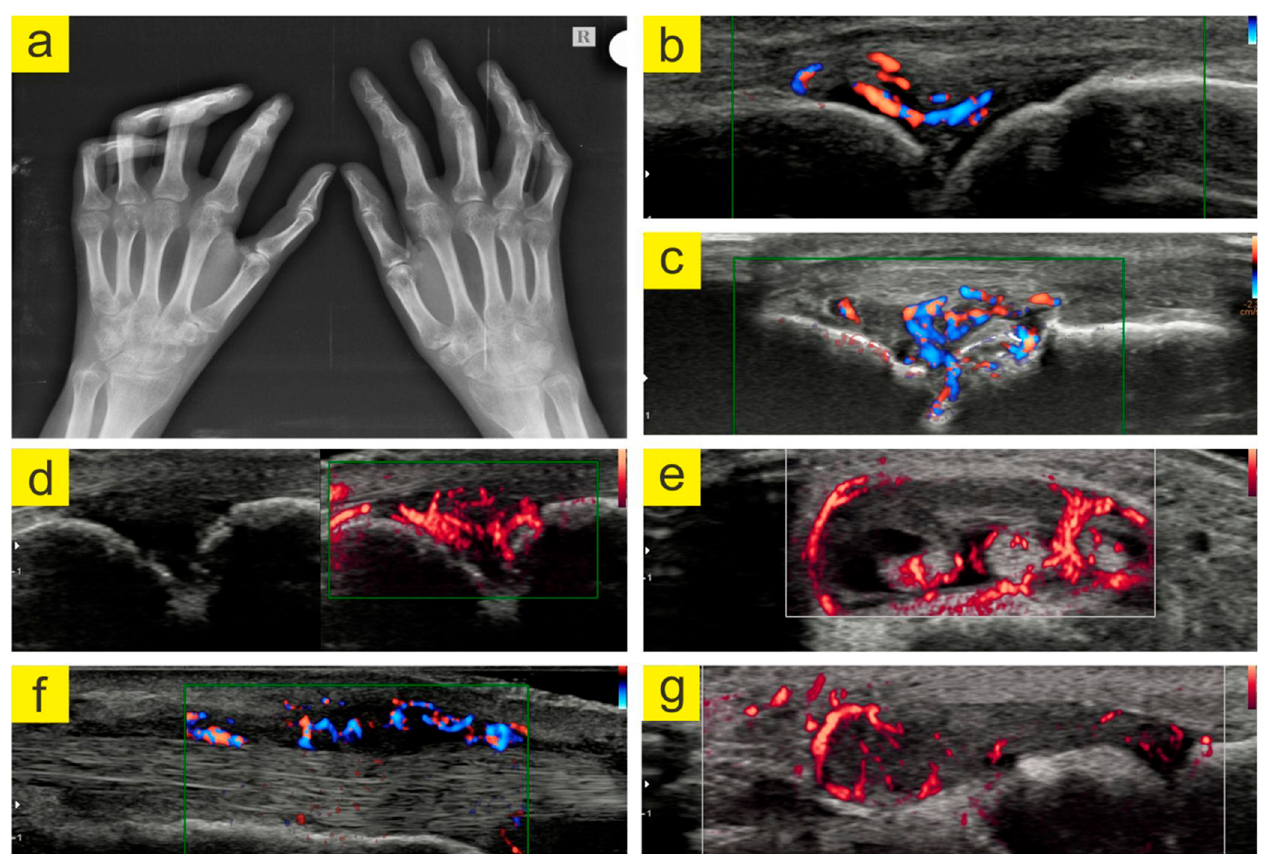
Figure 2. ( a ). Bilateral AP hand radiography. Radiological imaging identi fi ed multiple marginal ero- sions; narrowing of the proximal and distal interphalangeal, metacarpophalangeal, carpo-metacarpal, and carpal bone joints in both hands; osteoporosis in the band; subluxation proximal interpha- langeal II, III, IV, and V of the left hand; proximal interphalangeal IV and V of the right hand, and metacarpophalangeal IV and V of the right hand. ( b ). Hyper vascular synovial pannus (directional power Doppler). ( c ). Synovial pannus and bone erosion (directional power Doppler). ( d ). Hyper vascular synovial pannus (microvascular fl ow). ( e ). Tenosynovitis extensor tendons of the fi ngers (microvascular fl ow). ( f ). Synovial pannus radial extensor of the carpus and ulnar extensor of the carpus. ( g ). Synovial pannus at the MTF I joint level (microvascular fl ow). (Images archive of the fi rst author.)